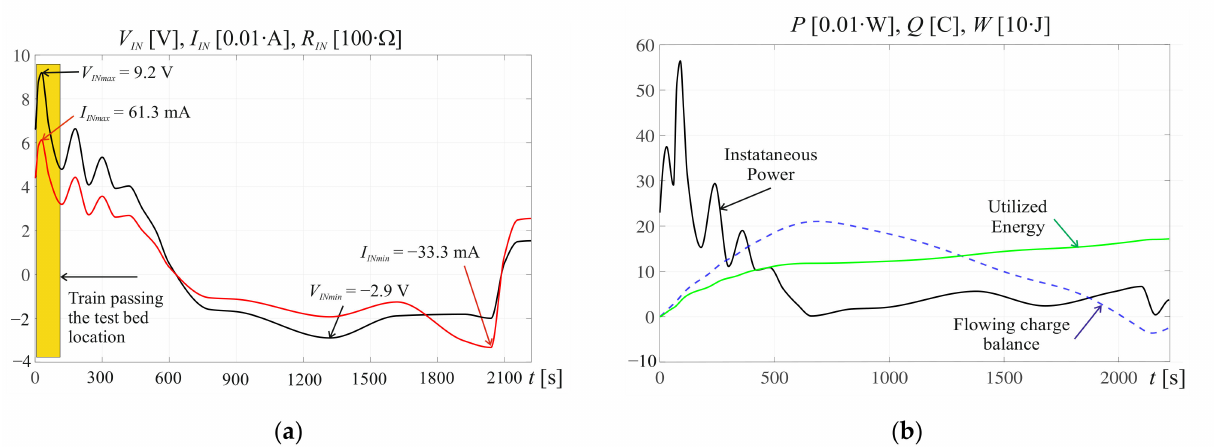
Figure 7. One heavy, slow train (20 km/h) passing, 2280 s of measurements for the matched input resistance R IN = 150 Ω : P max = 0.564 [W], P av = 0.0763 [W] and W = 172 [J]: ( a ) Voltage (black) and current (red) on the input of the converter; ( b ) The instantaneous power (black), the utilised energy (green) and the flowing charge balance